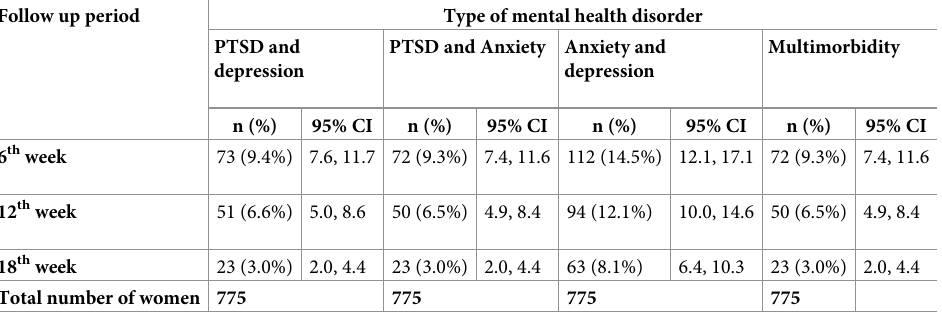
Table 3. Prevalence of Comorbid depression, anxiety and PTSD among postpartum women in Northwest Ethio- pia, 2021. Follow up